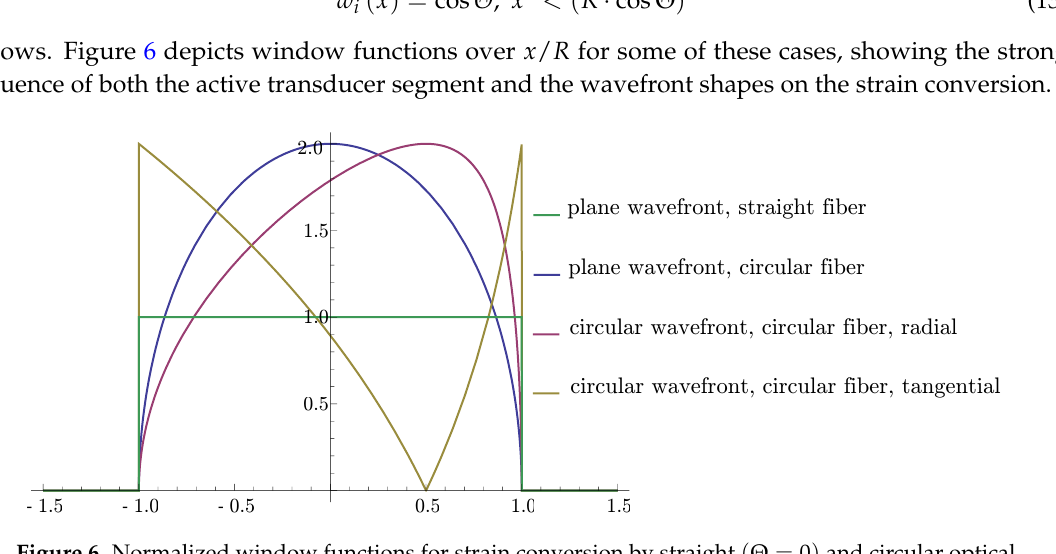
Figure 6. Normalized window functions for strain conversion by straight ( Θ = 0 ) and circular optical fibers. Plane and circular wavefronts are considered. The circular crested waves emerge at a distance d = 2 R